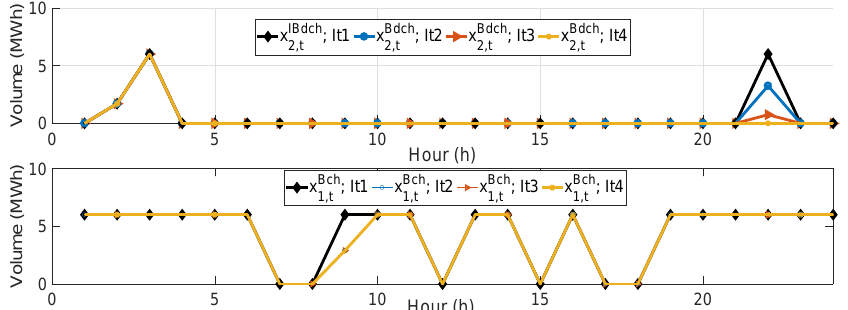
Figure 7. The optimal coordinated bidding in the real-time market for four iterations of rolling planning ( χ = 0.1).